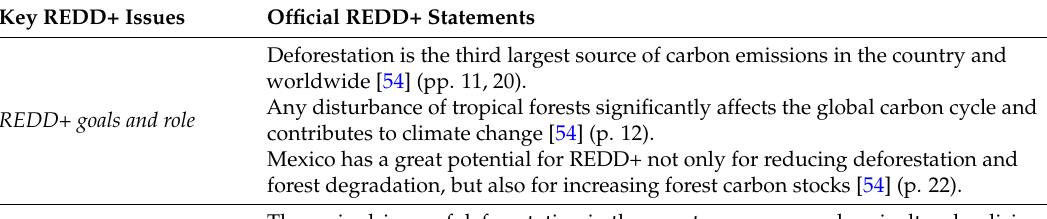
Table 4. Quotes related to the ten key REDD+ issues extracted from the analysed documents and paraphrased for length. Source: own elaboration from the sources indicated in the Table. FCPF, Forest Carbon Partnership Facility; PES, payment for ecosystem